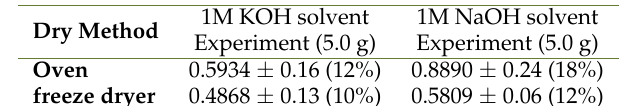
Fig. 1. Chemical structure of different type of carrageenan. Table 1. Yield of extracted sample using oven and freeze dryer as a drying method.